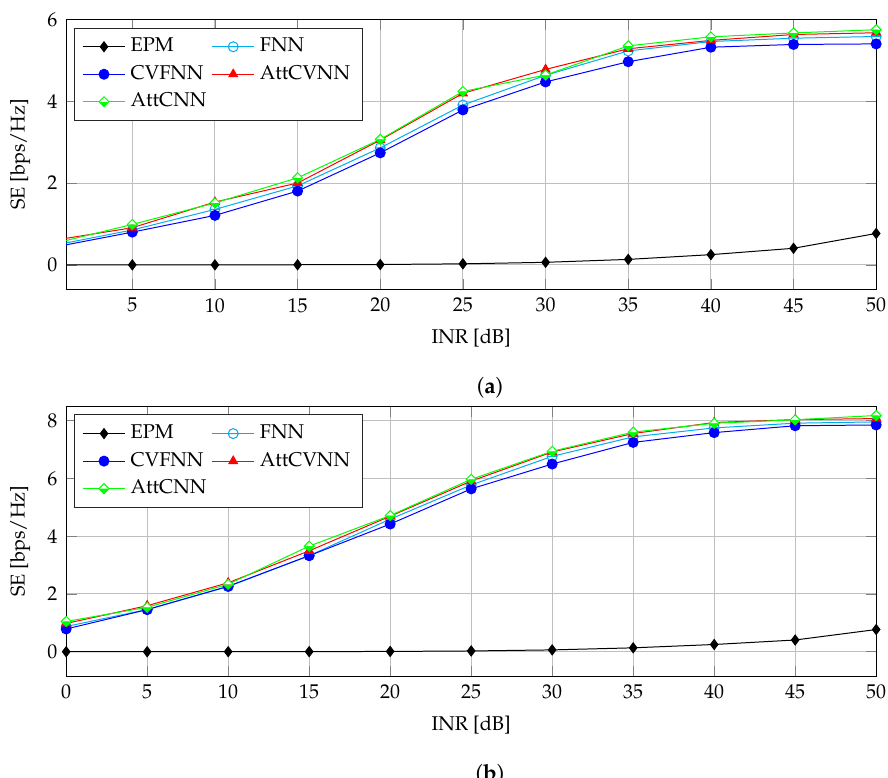
Figure 7. SE versus INR for the configuration SNR CB = 70 dB: ( a ) SNR PB = 60 dB; ( b ) SNR PB = 50